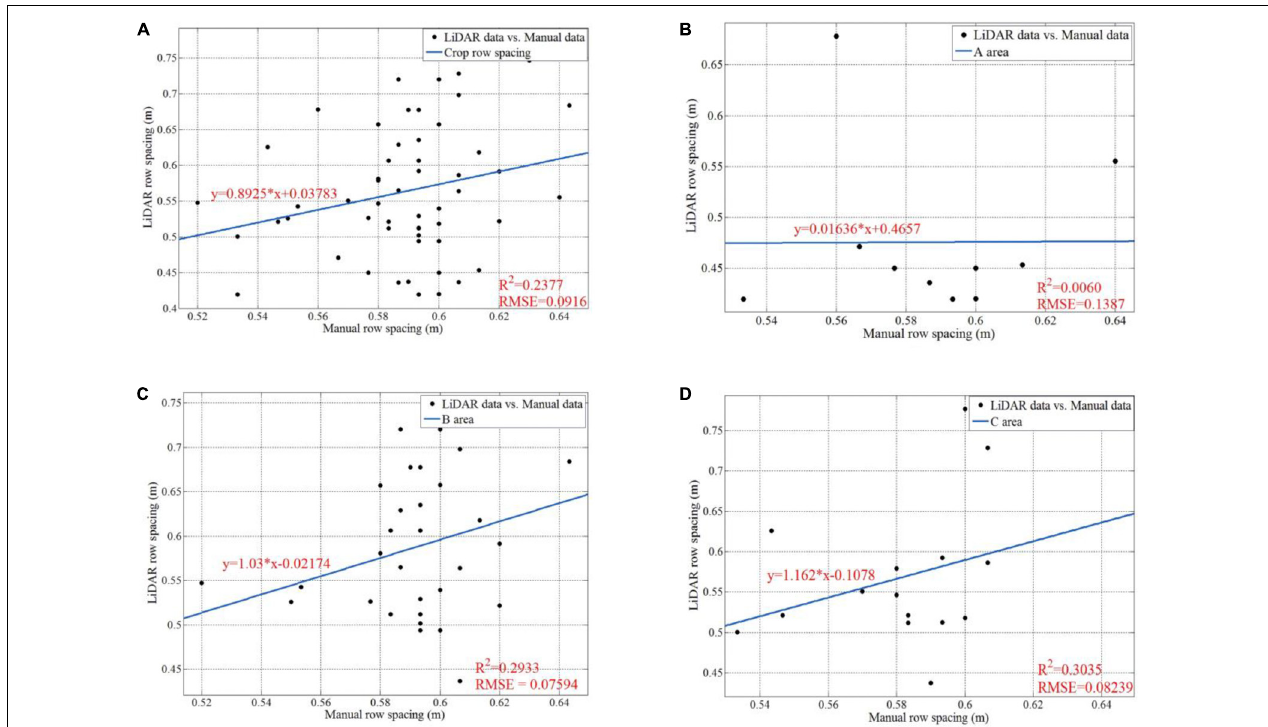
FIGURE 18 | Data analysis for manually sampled and calculated results of row spacing. (A) Is the regression line, the R square, and the RMSE for all the 57 row spacing values; (B) is the regression line, the R square, and the RMSE for the row spacing values in Area A; (C) is the regression line, the R square, and the RMSE for the row spacing values in Area B; (D) is the regression line, the R square, and the RMSE for the row spacing values in Area C.